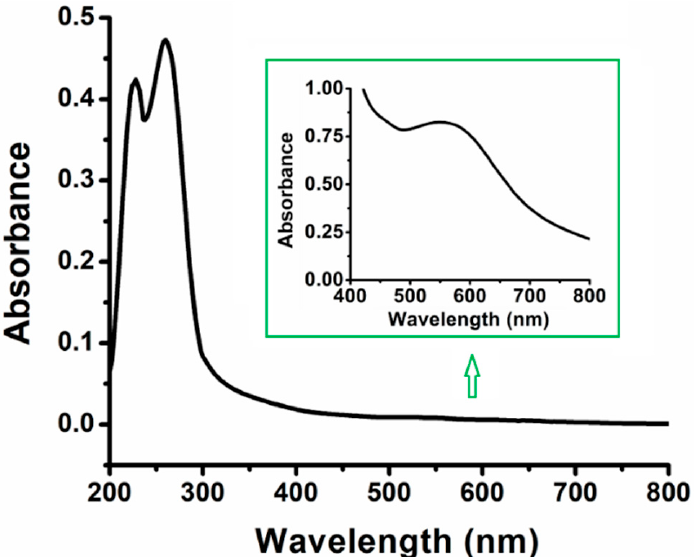
Figure 3. UV–Vis absorption spectra of complex 3 in CH 3 CN. (conc: 5 × 10 − 5 M; Inset conc: 5 × 10 − 3 M). The cyclic voltammogram of complex 3 is shown in Figure 4. The CV of the ligand ( 2 ) showed two irreversible reduction peaks at − 1.75 and − 1.365 V and an oxidation peak at 0.700 V. The copper(II) complex 3 showed a shift in the reduction peak in the potential range from 0 to − 0.785 V vs. Fc + /Fc [4,32,33]. Complex 3 exhibits an intense irreversible oxidation peak at E pa = 1.069 V in comparison with the oxidation peak found in the